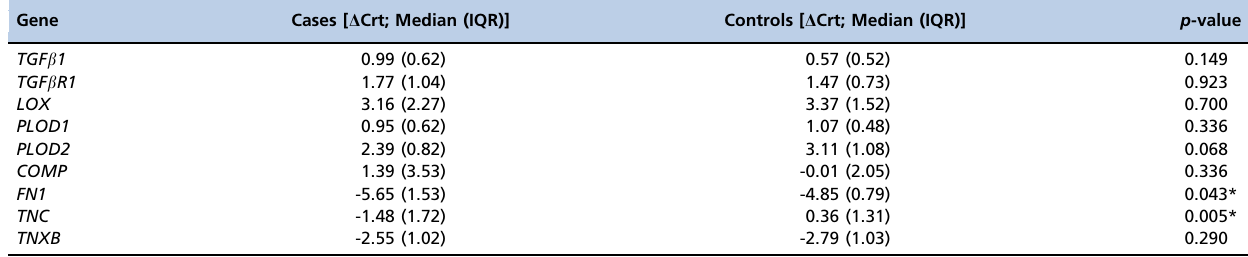
Table 3 - Gene expression patterns in the glenohumeral capsules of patients with adhesive capsulitis and in controls. Gene Cases [ D Crt; Median (IQR)] Controls [ D Crt; Median